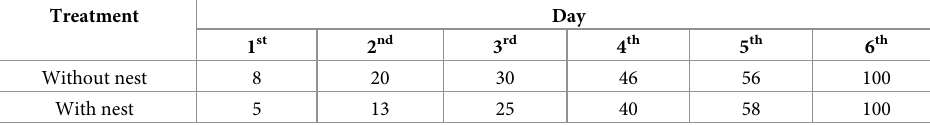
Table 7. Percentage of mortality for termites after assay test on WPCs for 1 week.